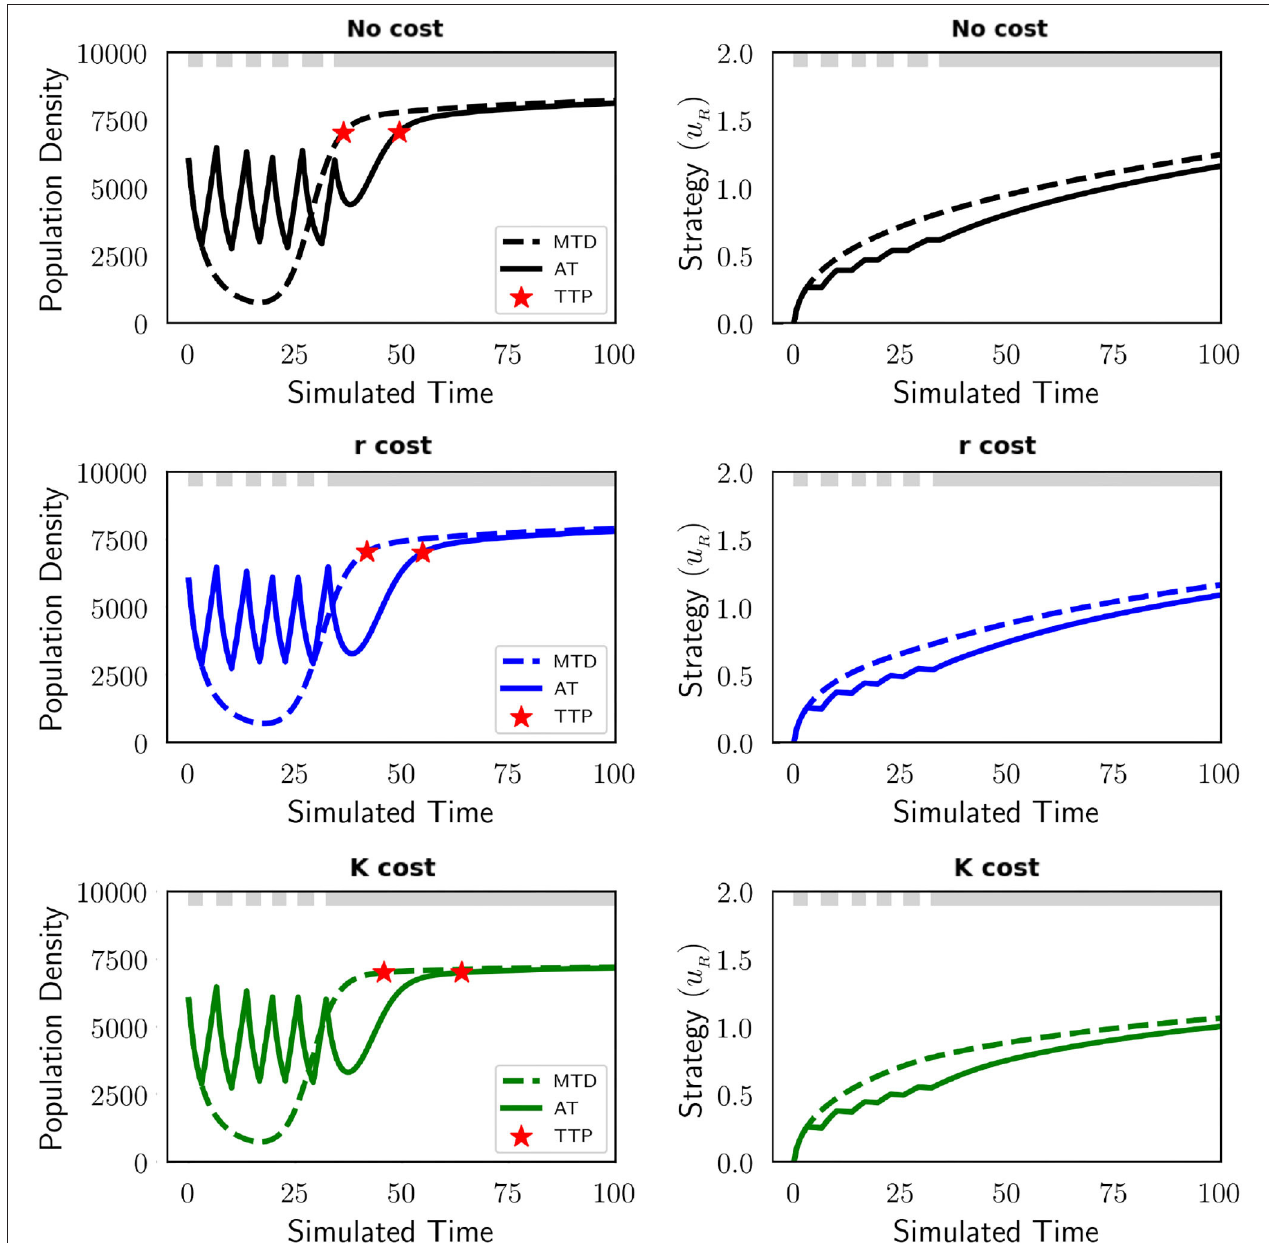
FIGURE 2 | AT is superior to MTD independent of the cost of resistance. Simulations of AT (solid line) and MTD (dashed line) for a polymorphic population are shown in the absence of a resistance cost (black), and when the cost impacts the intrinsic growth rate (blue) and carrying capacity (green). Population dynamics (left) and evolutionary dynamics (right) illustrate the advantage of AT compared to MTD. The protocol for AT is to withdraw the drug once the population density ≤ 3,000 (50% of the initial population size). Drug administration for AT is shown at the top of each plot in gray. TTP for each is illustrated by red stars. Only the strategy for the resistant population is shown as the sensitive population has a fixed strategy ( u s = 0). Regardless of the cost of resistance, AT always corresponds to a longer TTP. The parameters used in this figure are: m = 1, K max = 10,000, r max = 0.45, k = 2, b = 10, d = 0.01, g = 0.1, σ =